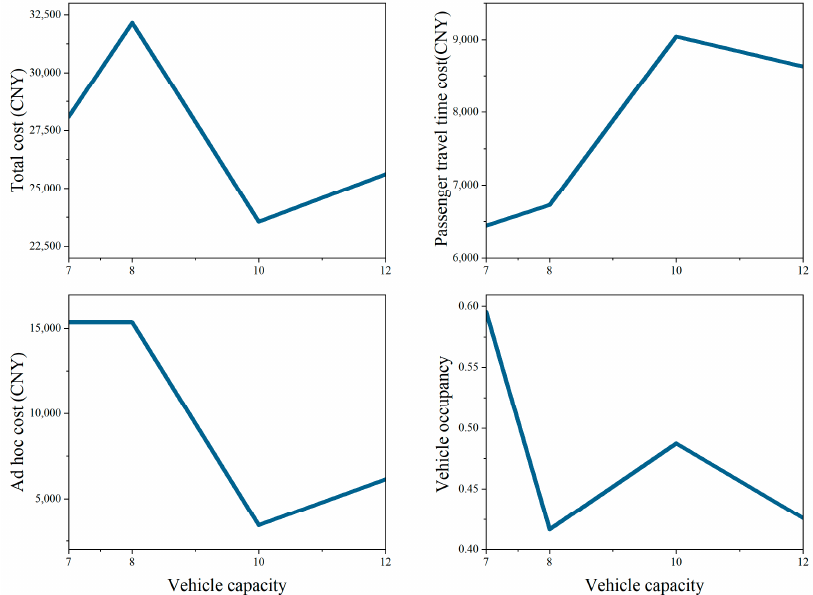
Figure 7. Sensitivity analysis of vehicle capacity.